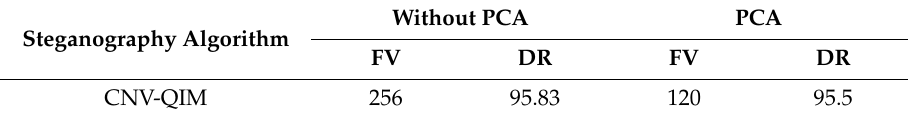
Table 2. PCA test results (%). FV denotes feature vector, and DR expresses detection rate. Steganography Algorithm